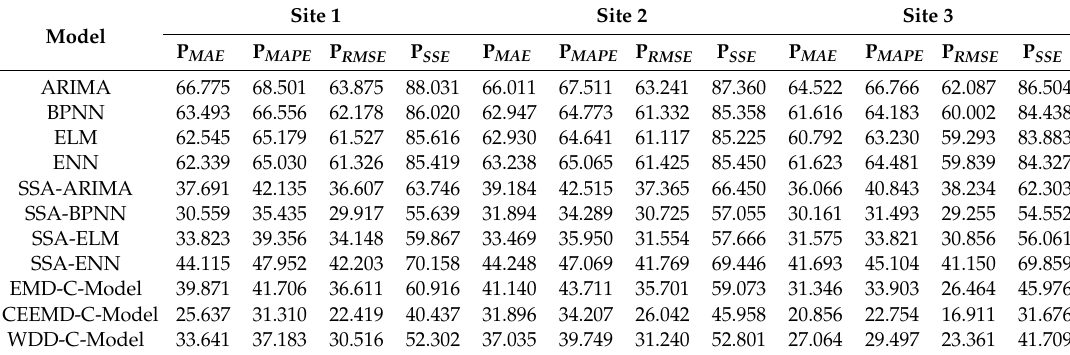
Table 11. Improvement percentages of the proposed model relative to selected